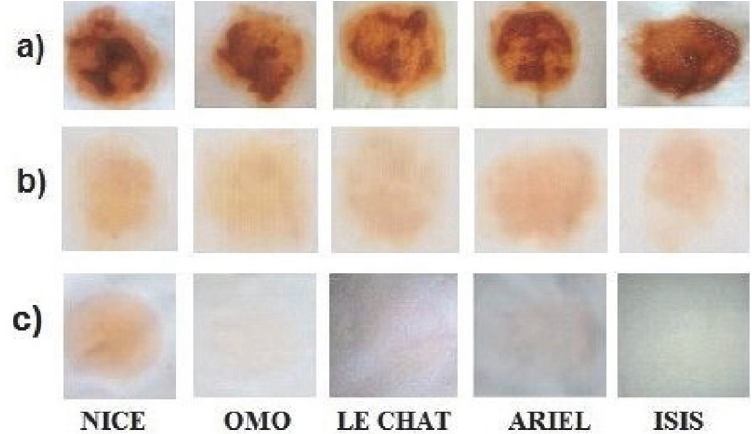
Figure 9 . Cloth pieces stained with mixture of sauce sample and fat/greasy material, were washed with commercial laundry detergent (7 mg/mL) added with AKL29 (50 U/mL). Untreated cloth pieces taken as control (a), and treated cloth pieces by detergent alone (b), and treated cloth pieces by detergent with lipase (c).